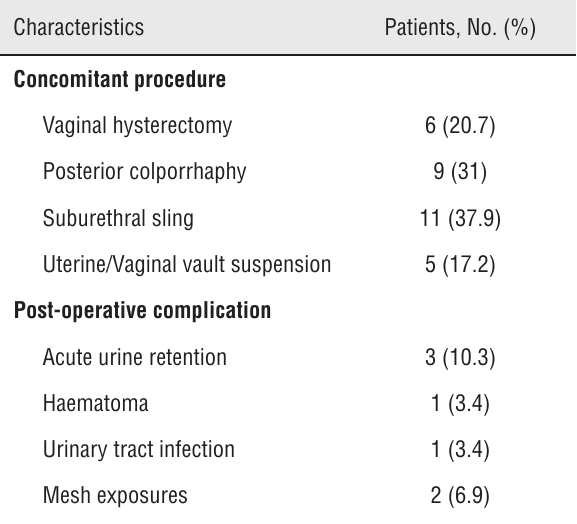
Table 4 – PFDI-20 Scores (recurrence vs no